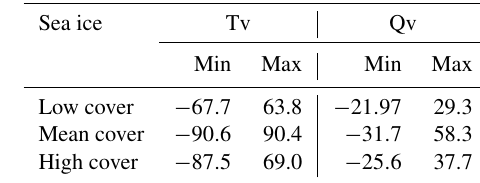
Table 1. Minimal and maximal values for atmospheric meridional heat (Tv) and moisture (Qv) transport along a transect at 70 ◦ N. Values were divided by the mean of each grid cell. Distributions of values for both variables are displayed as boxplots in Fig.